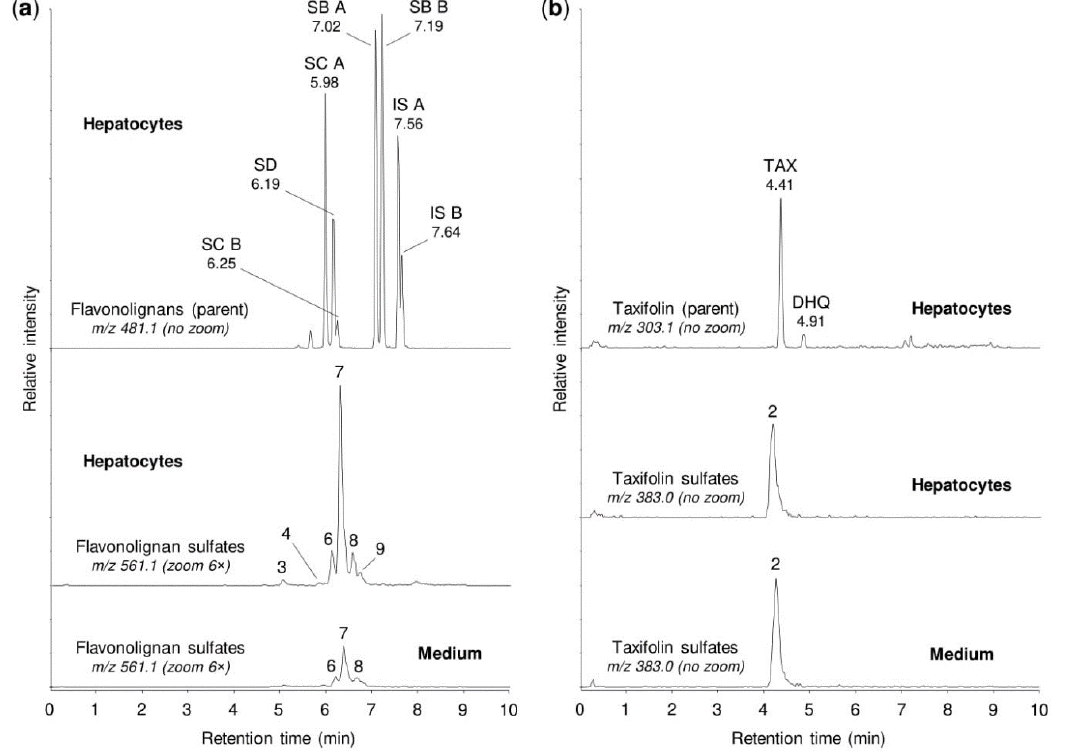
Figure 4. Sulfation of silymarin mixture by human hepatocytes. The suspension of human hepatocytes was incubated for 1 h with silymarin (50 µM), and then the cells and medium were analyzed by the UHPLC-MS method. ( a ) The representative chromatograms show the parent flavonolignans, i.e., silydianin (SD), silychristin A (SC A), silychristin B (SC B), silybin A (SB A), silybin B (SB B), isosilybin A (IS A), isosilybin B (IS B), and their sulfation products. ( b ) The representative chromatograms show the parent taxifolin (TAX), a dihydroquercetin isomer (DHQ), and their sulfation products. The peaks of sulfates are marked with numbers corresponding to those in Figure 2. For details on the peaks, see Table 3. To enable comparisons between analyses, the signal intensity in chromatograms was adjusted to the same value within each panel (3.05 × 10 5 in ( a ), 1.00 × 10 4 in ( b )), before using the zoom tool where appropriate.